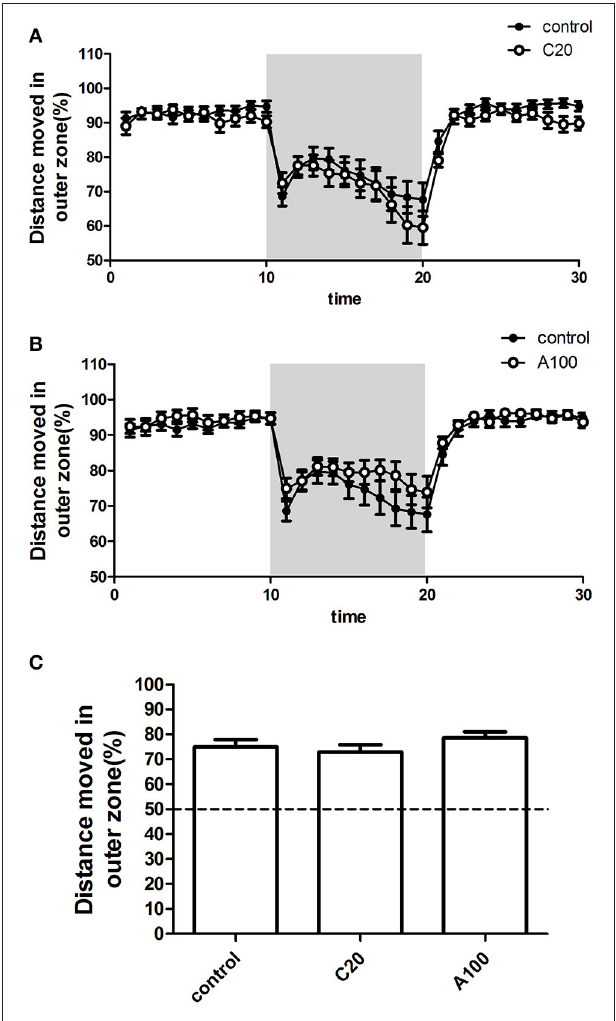
FIGURE 5 | Effects of chronic or acute exposure to VPA on thigmotaxis of zebrafish at 1 month of age. Distance moved in outer zone (%) in alternating 10-min blocks of light and dark. The control group (filled circles) was plotted with chronic exposure to 20 µ M VPA (open circles) and acute exposure to 100 µ M VPA (open circles) in (A,B) , respectively. The shaded part in each panel represents the dark phase, and the non-shaded part in each panel represents the light phase. Average distance moved in the outer zone (%) during the 10-min dark phase was plotted in (C) . The data are presented as the mean ± SEM, n = 32 animals per group. Statistical markers: * p < 0.05; significantly different from the